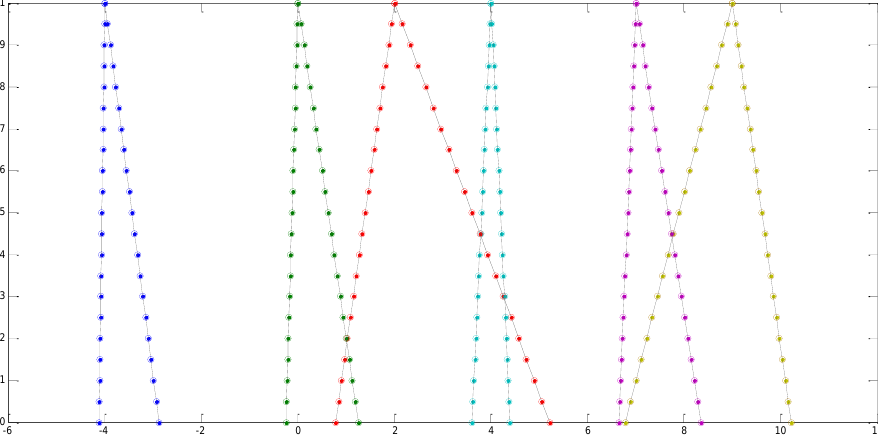
Figure 3. The Hausdorff distance of solutions with 𝜀 = 10 −3 in successive over-relaxation (SOR) method with 𝜔 = 1.3 is 5.5611 × 10 −4 .